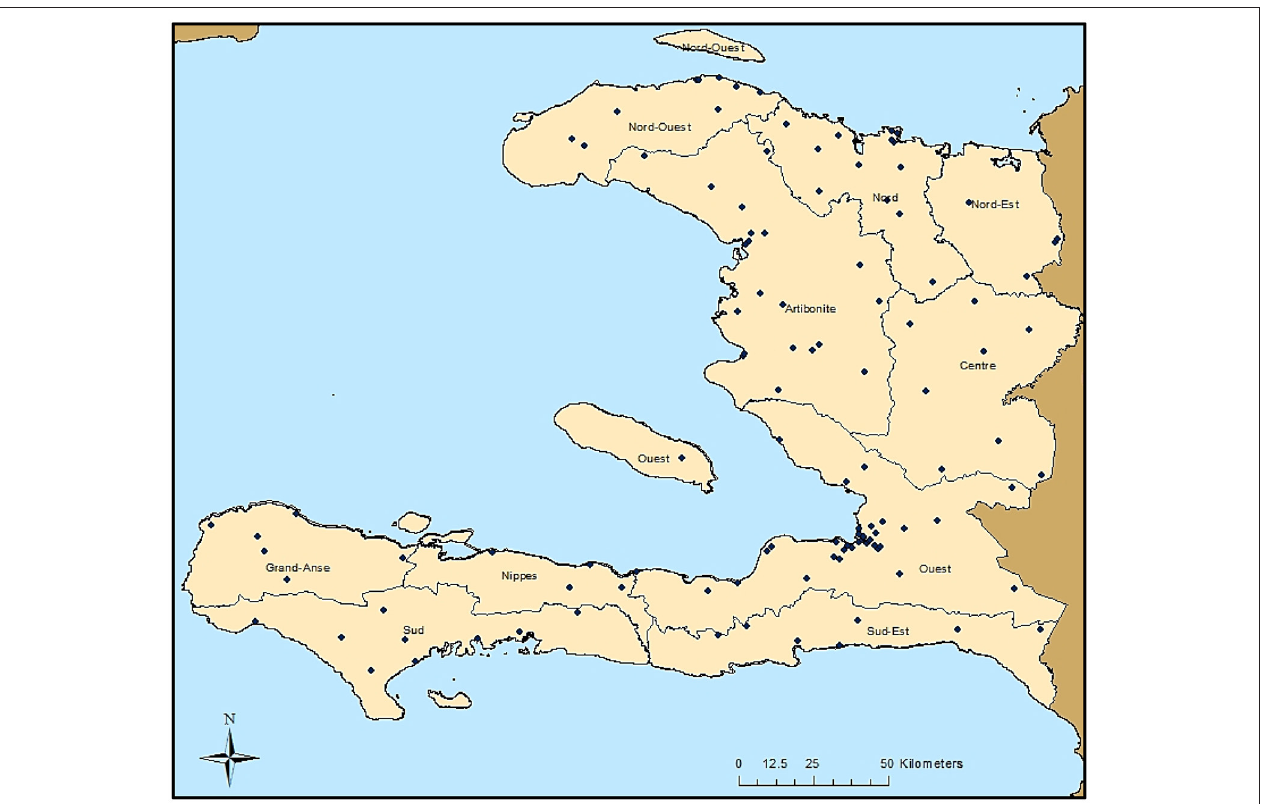
FIGURE 1 | Sampling Locations in Haiti from the 2014/2015 Nationwide Survey. Each of the 117 sampling locations are indicated by a black dot. Boundaries of the ten Haitian departments are also shown.